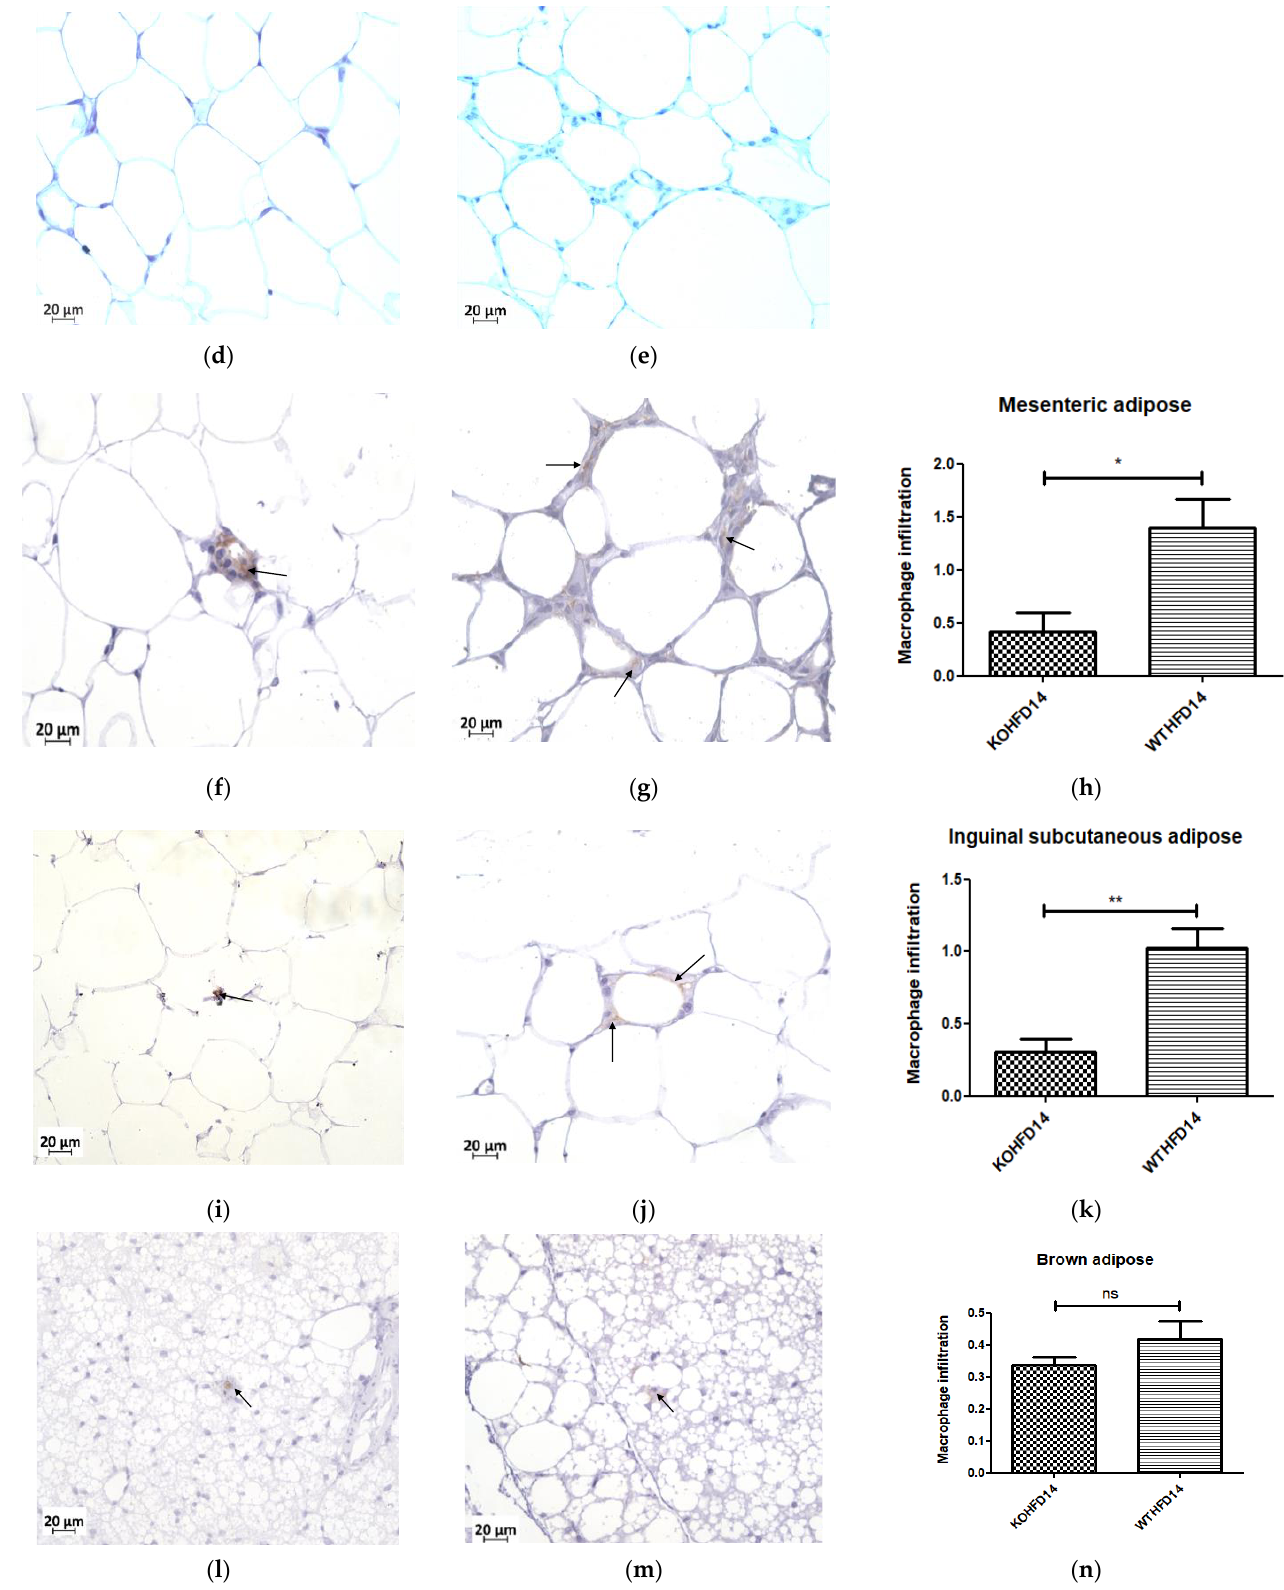
Figure 11. Effect of slc7a8 deletion on macrophage infiltration in adipose tissue. KOHFD ( a ) showed a significant decrease in macrophage infiltration (indicated by black arrows) in pWAT ( p < 0.01), ( c ) compared to WTHFD ( b ). ( d , e ) represent the negative controls for KOHFD and WTHFD,